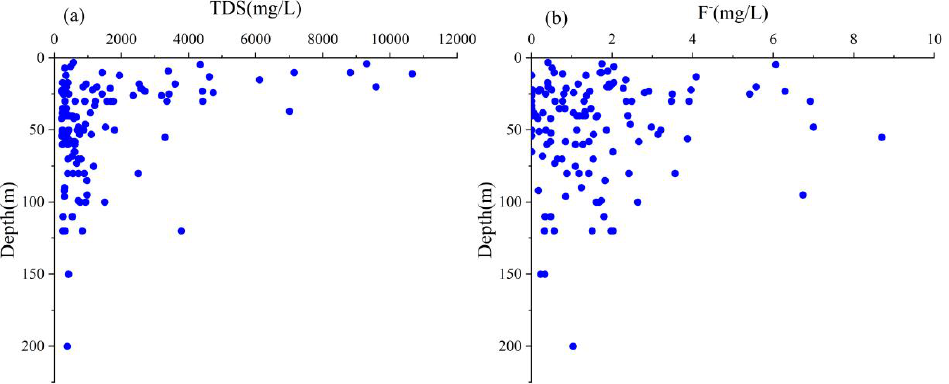
Figure 4. Vertical distribution of groundwater ( a ). TDS and ( b ) Fluoride concentrations in the study